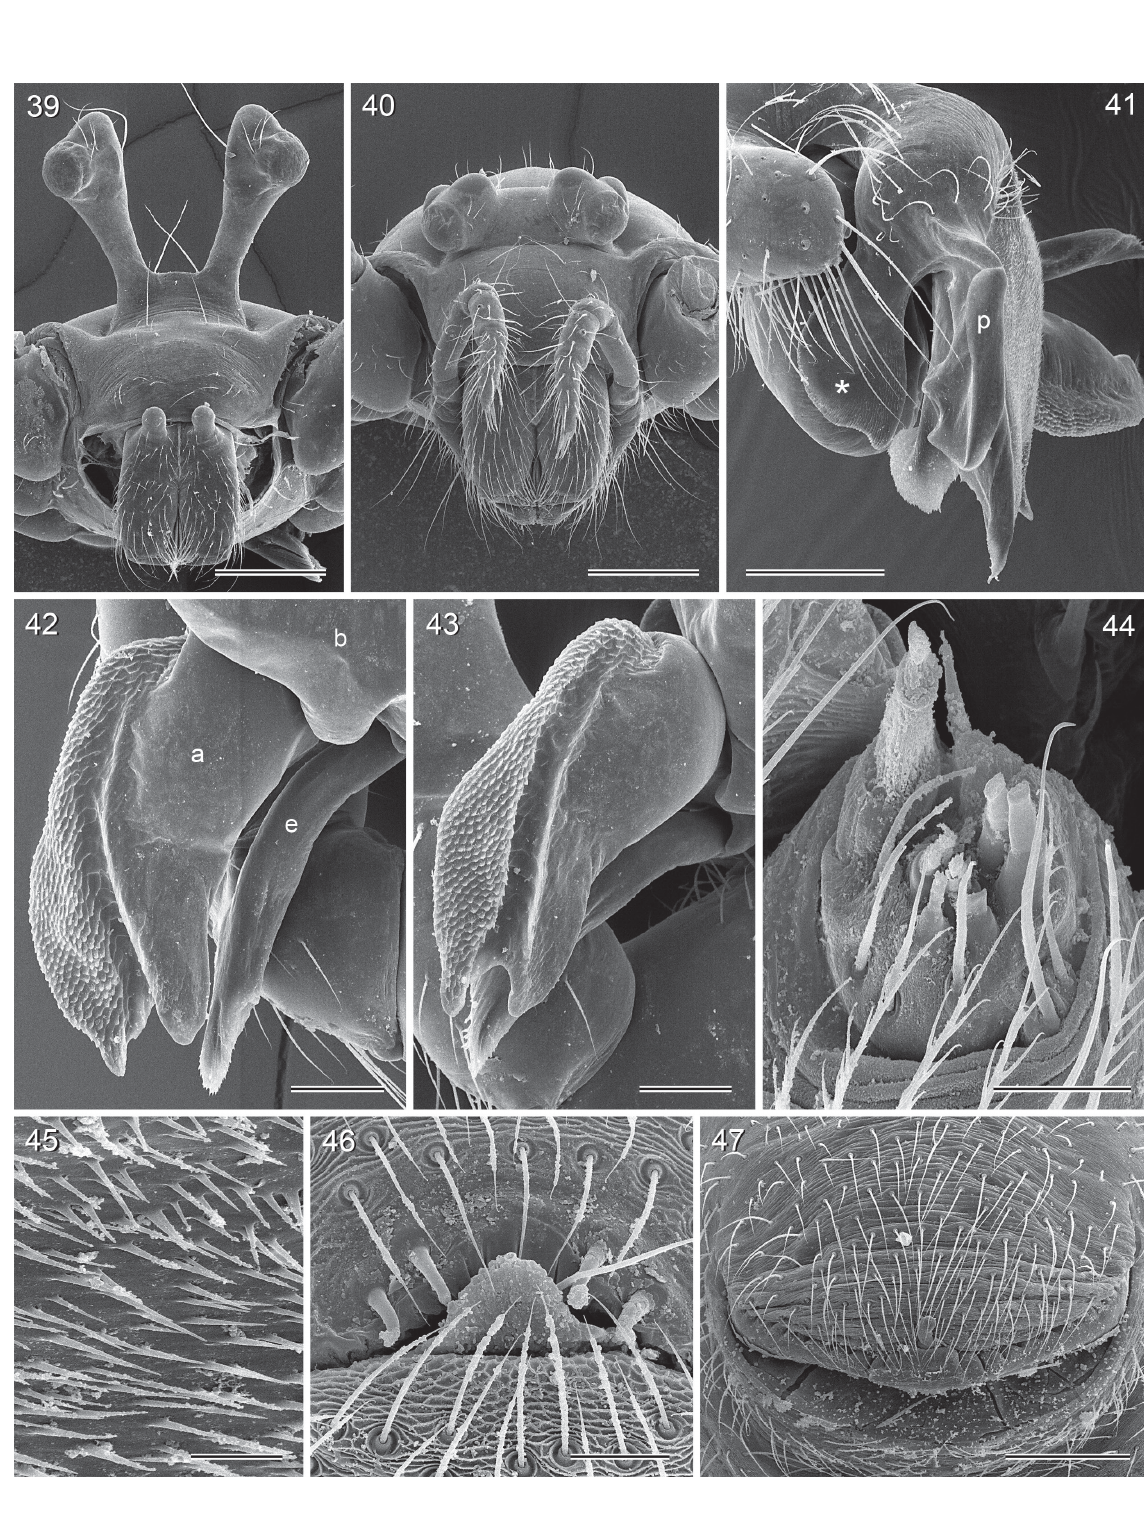
Figs 39–47. Pholcus gombak Huber, 2011, SeM micrographs (ZFMK, Ar 15701–02). 39–40 . Male and female prosomata, frontal views. 41 . Left procursus; asterisk marks large prolatero-dorsal process. 42– 43 . right appendix and embolus, prolateral and prolatero-distal views. 44 . Female ALS. 45 . Cuticular processes on whitish retrolateral area of left procursus. 46 . Male gonopore. 47 . epigynum, ventral view. Scale bars: 39–40 = 300 µm; 41, 47 = 200 µm; 42, 43 = 100 µm; 44 = 20 µm; 45 = 10 µm; 46 = 30